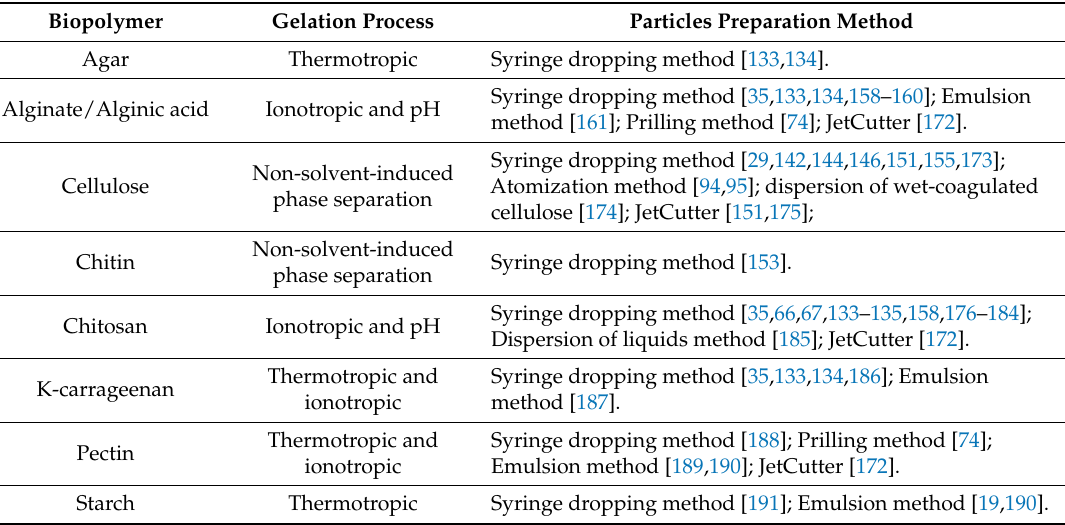
Table 1. Bio-aerogels in form of particles produced by different gelation methods and dried with supercritical CO 2